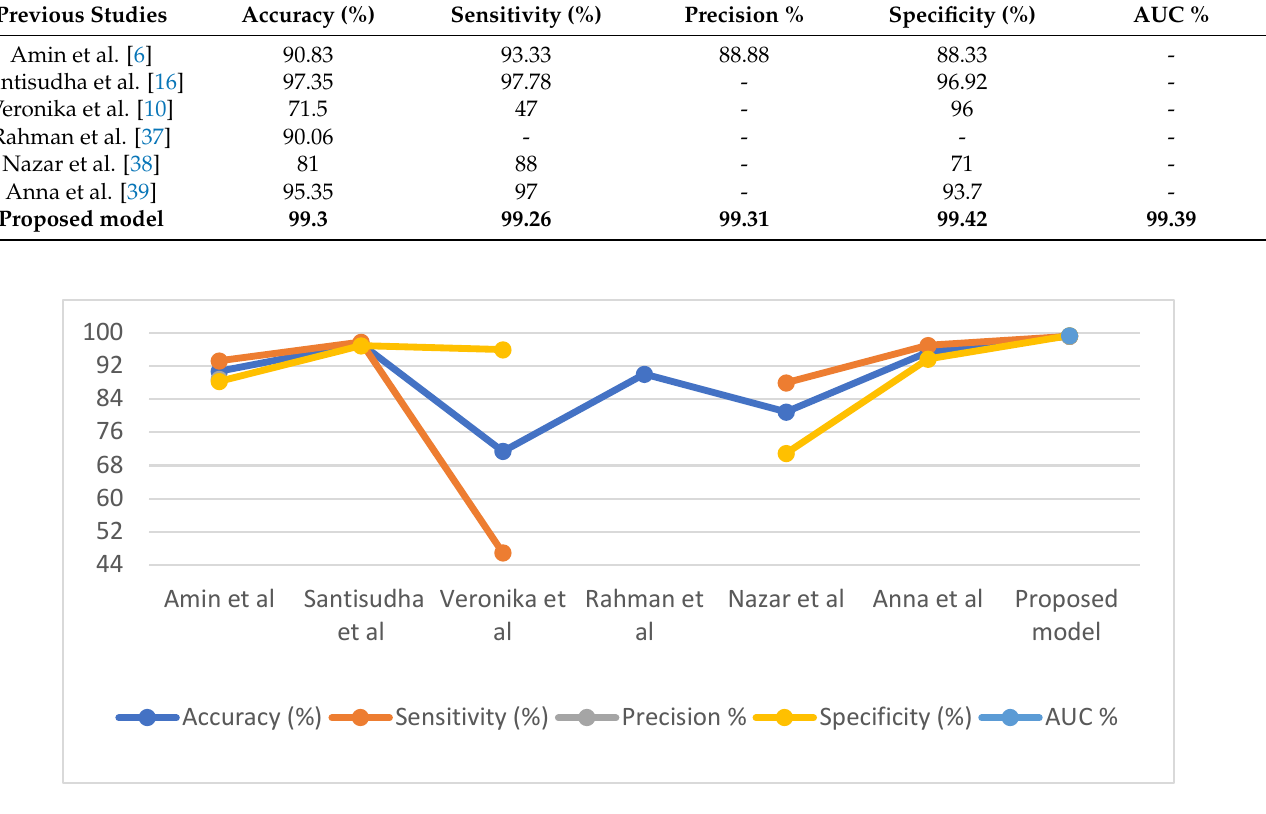
Figure 17. Comparison of the performance of our system with previous studies for diagnosing oral squamous cell carcinomas